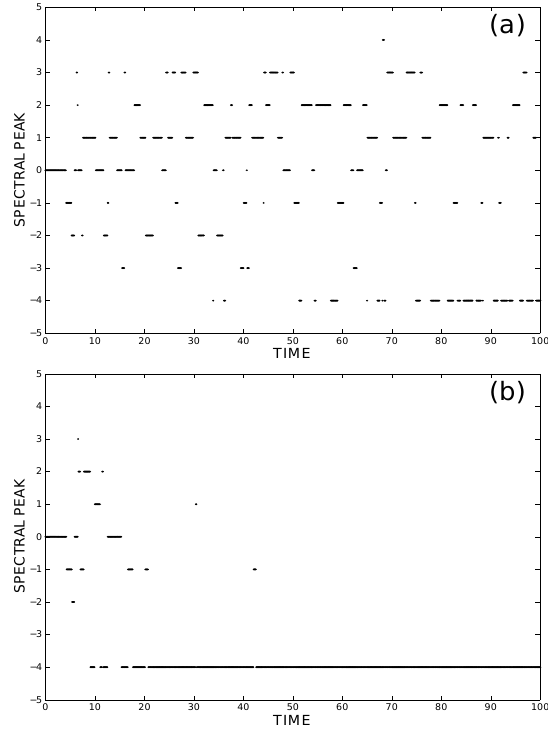
Fig. 10. The HONLS equation with nonlinear damping (cid:15) = 0 . 05, Fig. 10: The HONLS eq. with nonlinear damping ǫ = 0 . 05 , Fig. 10: The HONLS eq. with nonlinear damping ǫ = 0 . 05 , β = 0 . 04, 0 = 0: time evolution of (a) the strength S(t) and (b) the β = 0 . 04 , Γ = 0 : time evolution of (a) the strength S ( t ) and β = 0 . 04 , Γ = 0 : time evolution of (a) the strength S ( t ) and main Fourier modes for initial data (17). (b) the main Fourier modes for initial data (17). (b) the main Fourier modes for initial data (17).